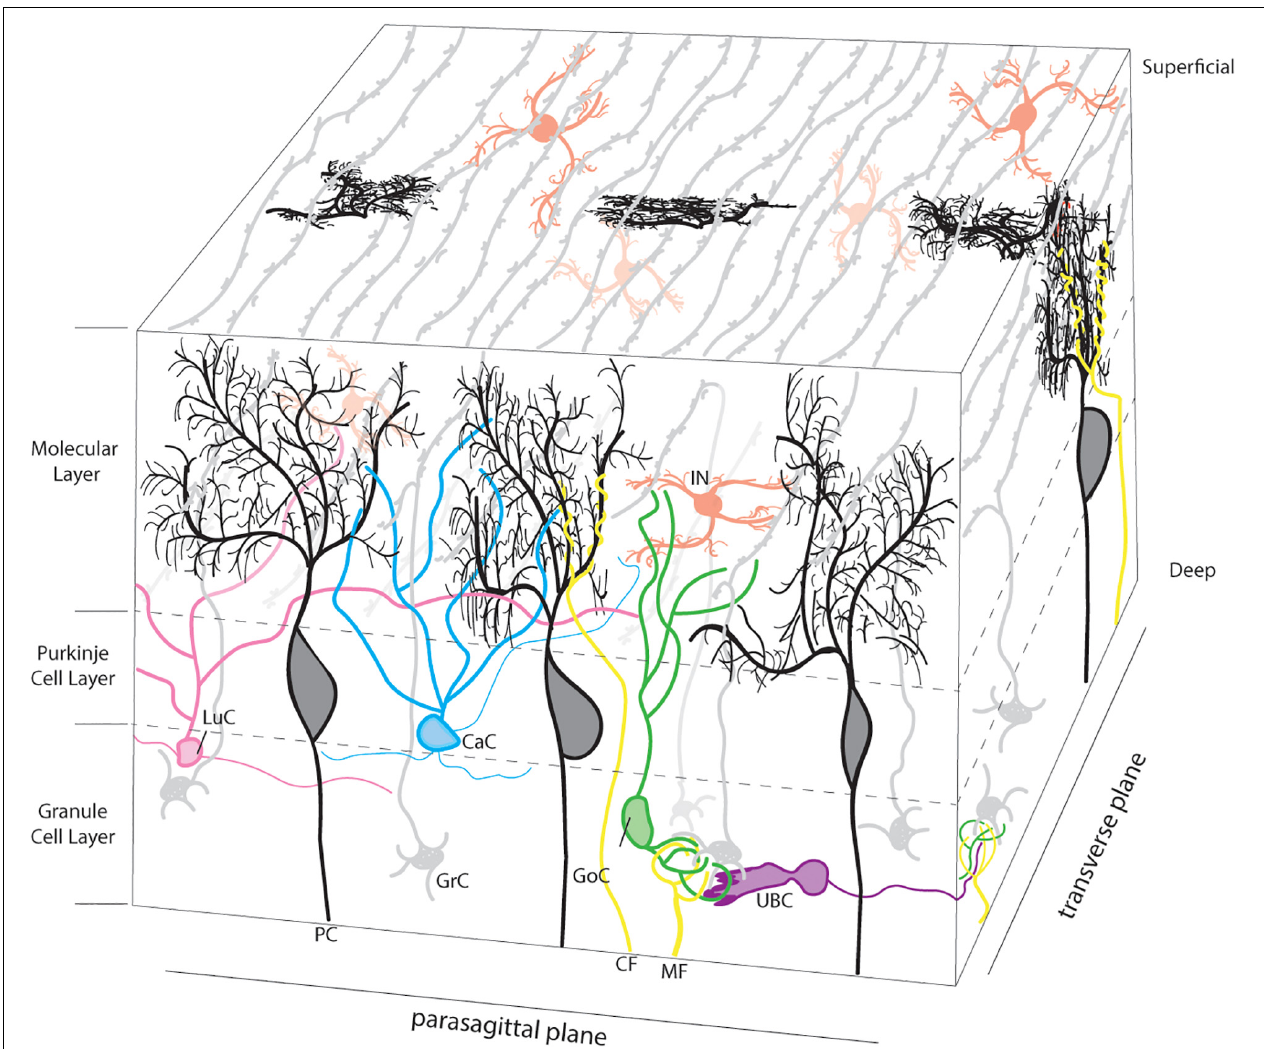
FIGURE 1 | Neuronal microarchitecture of the cerebellar cortex. Representative schema of the layers of the cerebellar cortex. Afferent projections are presented in yellow. Climbing fibers (CF; yellow) project to the molecular layer and target the dendritic tree of a single Purkinje cell (PC; black). Mossy fibers (MF; yellow) terminate in the granule cell layer, forming synaptic connections with granule cells (GrC; gray). The granule cell layer also contains golgi cell (GoC; green), Lugaro cell (LuC; pink), and unipolar brush cell (UBC; purple) interneurons. The cell bodies of granule cells are located in the granule cell layer and project axons to the molecular layer where they branch to form parallel fibers, which run orthogonal to the parasagittal plane. The molecular layer contains the cell bodies of inhibitory interneurons (IIN; red), which include both basket and stellate cells as well as neurites from a variety of neurons, as pictured. Finally, the Purkinje cell layer is occupied by the large cell bodies of the Purkinje cell (PC; black) and the smaller cell bodies of the Candelabrum cells (CaC; Cyan). In 3-dimensional space, the transverse projections of the parallel fibers can integrate and process the afferent information supplied by the climbing and mossy fibers. Basket cell axons, which wrap the Purkinje cell soma and initial segment of the axon, and Bergmann glia palisades that extend into the molecular layer were intentionally excluded to focus on the Purkinje cell